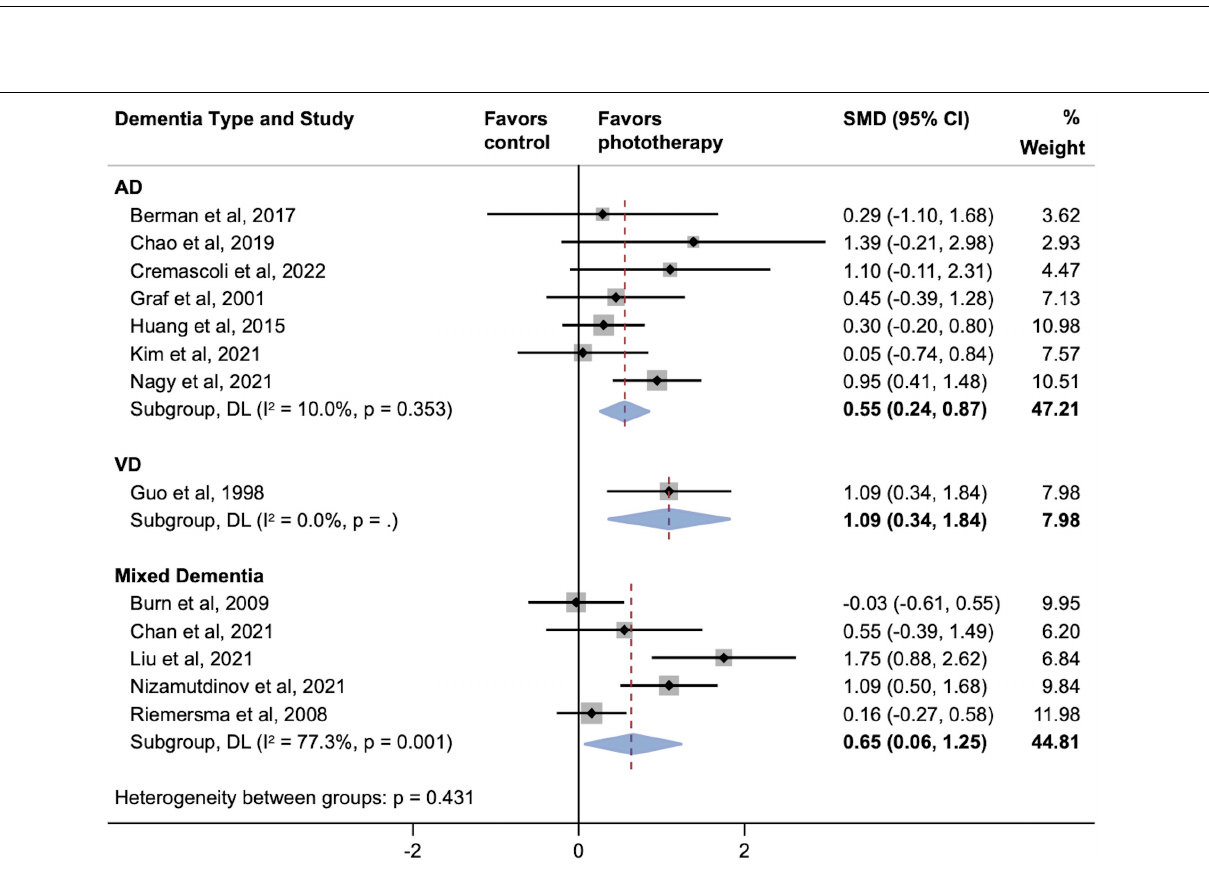
Frontiers in Aging Neuroscience |